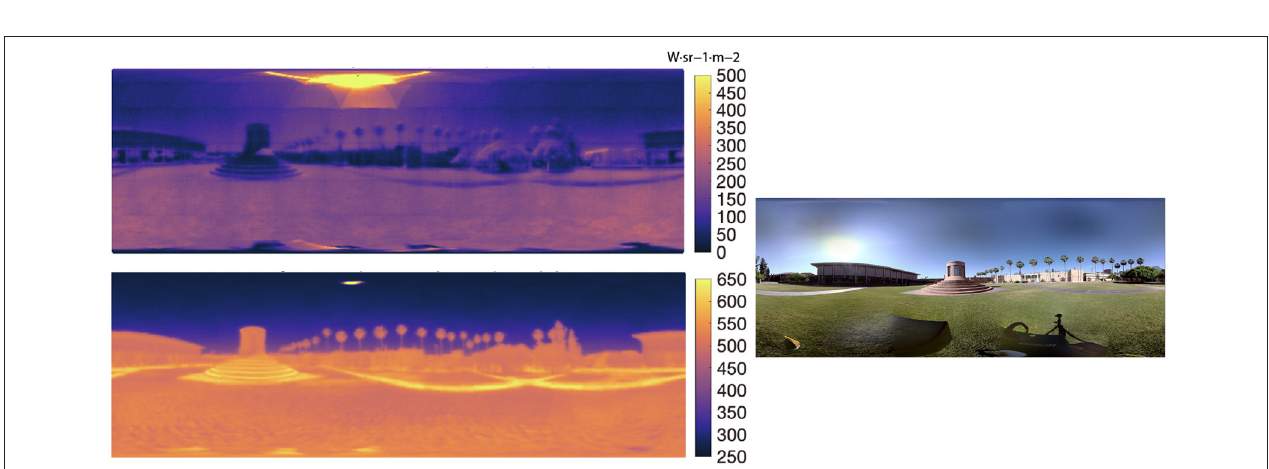
FIGURE 7 | (left) Hayden lawn Shortwave (top) and Longwave (bottom) radiant energy panorama at 2 pm from the SMaRT-SL sensor scan. (right) Hayden lawn visible panorama photo at 10 am, showing grass surfaces, sidewalks, and concrete buildings. Lambert cylindrical equal area projection used.